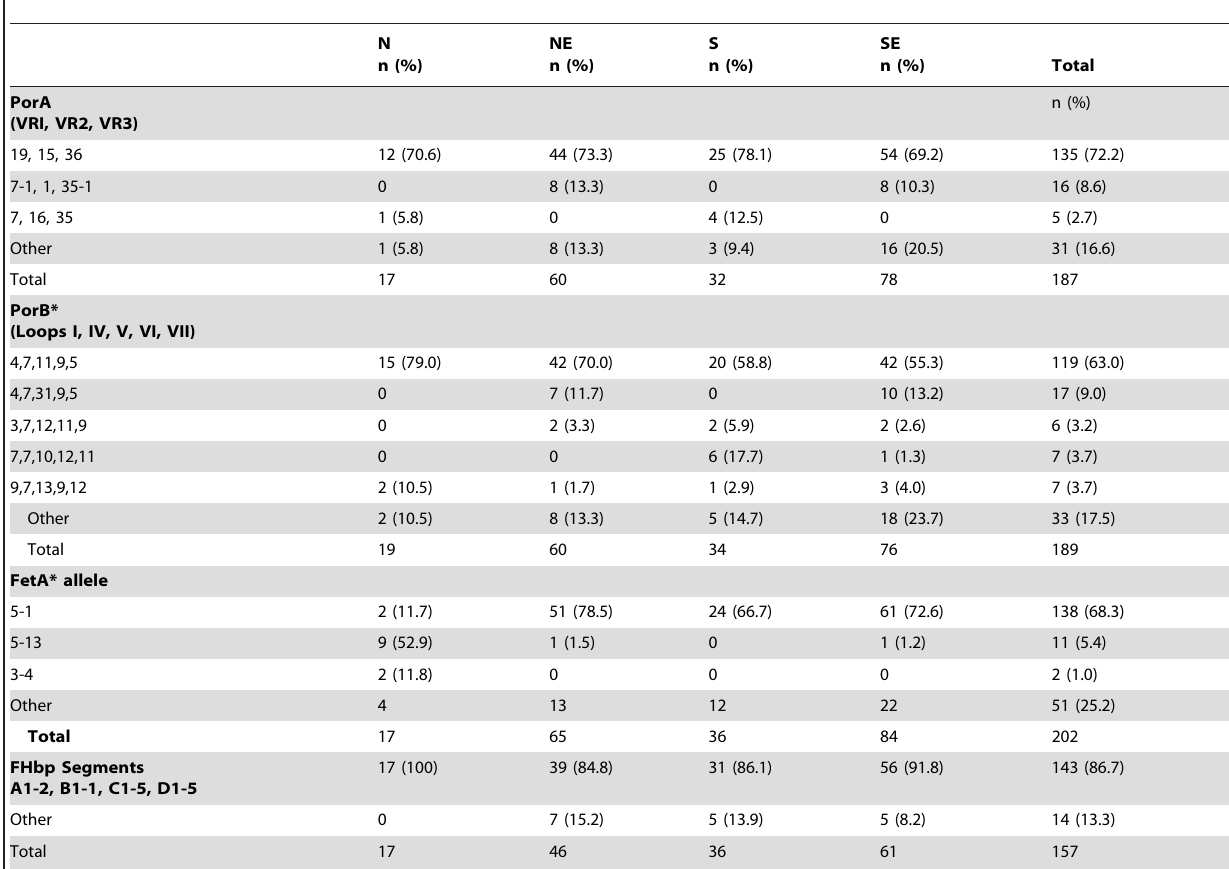
Table 1. PorA, PorB, FetA, FHbp by Region,